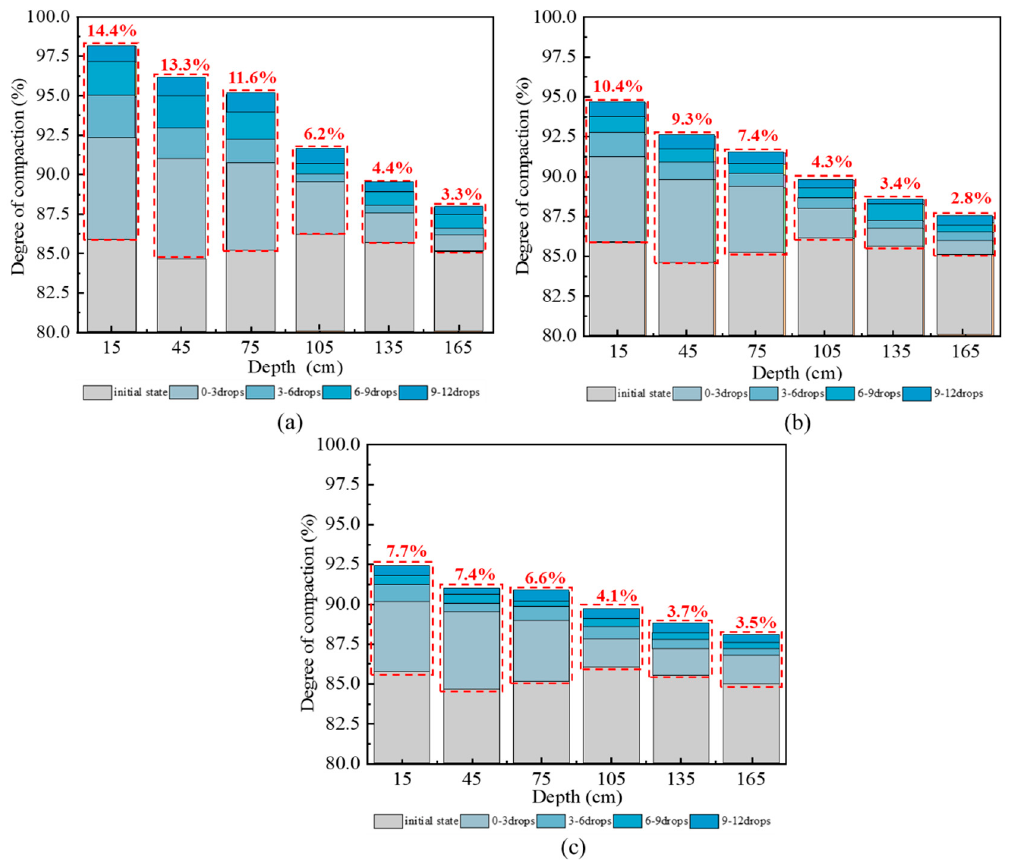
Figure 9. Incremental graph of layered compactness of reinforced subgrade: ( a ) condition 1; ( b ) Figure9. Incrementalgraphoflayeredcompactnessofreinforcedsubgrade: ( a )condition1; ( b )condition condition 2; ( c ) condition 3. 2; ( c ) condition